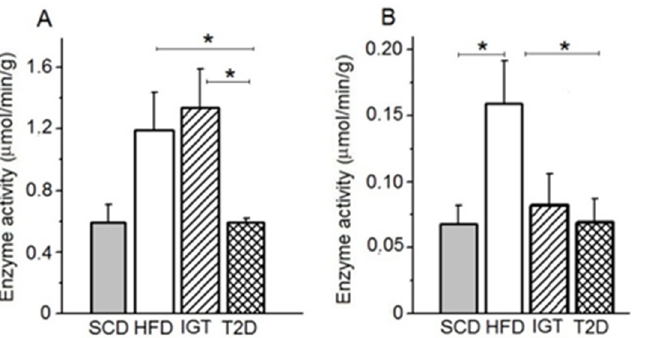
Figure 10. Activities of alkaline phosphatase and aminopeptidase N in the chime of the colon in rats with type 2 diabetes (T2D), with impaired glucose tolerance (IGT) and in control groups: high-fat diet (HFD) and standard chow diet (SCD). ( A ) Alkaline phosphatase activity; ( B ) aminopeptidase N activity. ( A , B ) The T2D group ( n = 4), the IGT group ( n = 6), the HFD group ( n = 6) and the SCD group ( n = 6). Student t -test: * p < 0.05.